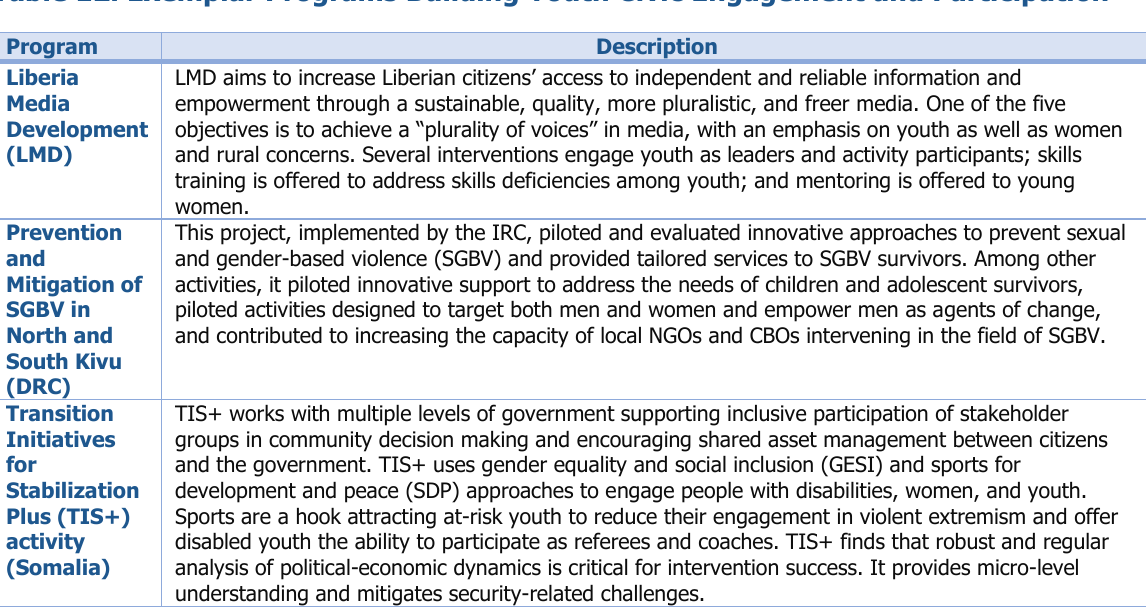
Table 12. Exemplar Programs Building Youth Civic Engagement and